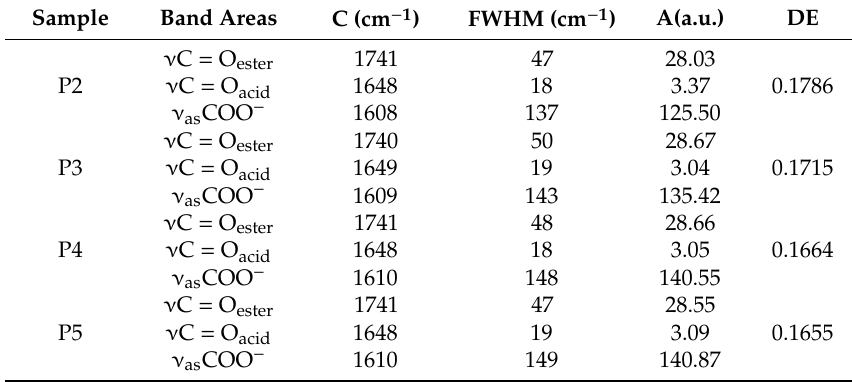
Table 4. Decomposition results of the 1800–1550 cm − 1 region of the DRIFT spectra: Centers (C), full width at half maxima (FWHM), integrated areas (A) of the ν C = O and ν as COO − band areas, and degree of esterification